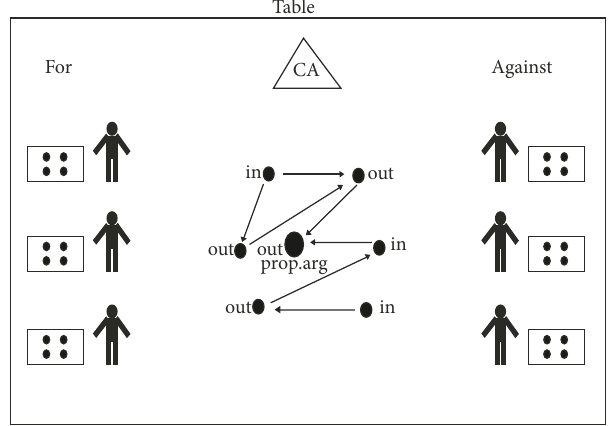
Figure 3: A representation of a table of deliberation between two groups of 3 agents with 4 arguments each. Each agent has advanced an argument. Agents tacitly agree on the attacks between the arguments. The CA determines the labeling using the grounded labeling-based semantics.